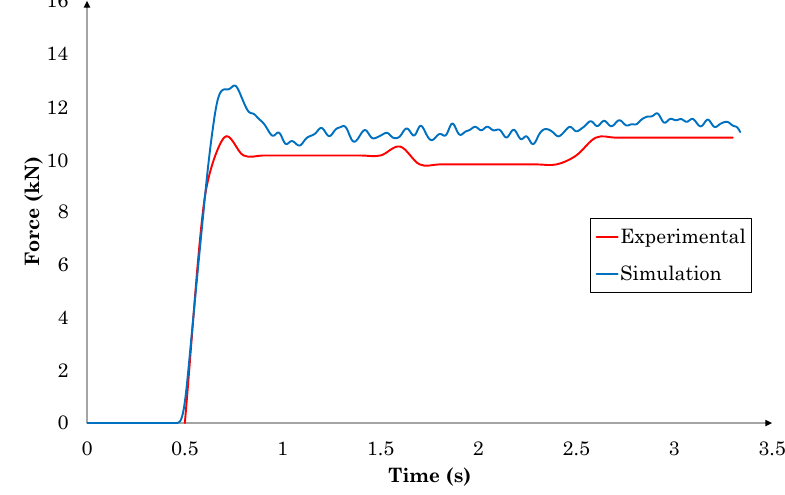
Figure 9. Comparison of the forces exerted by Diescher